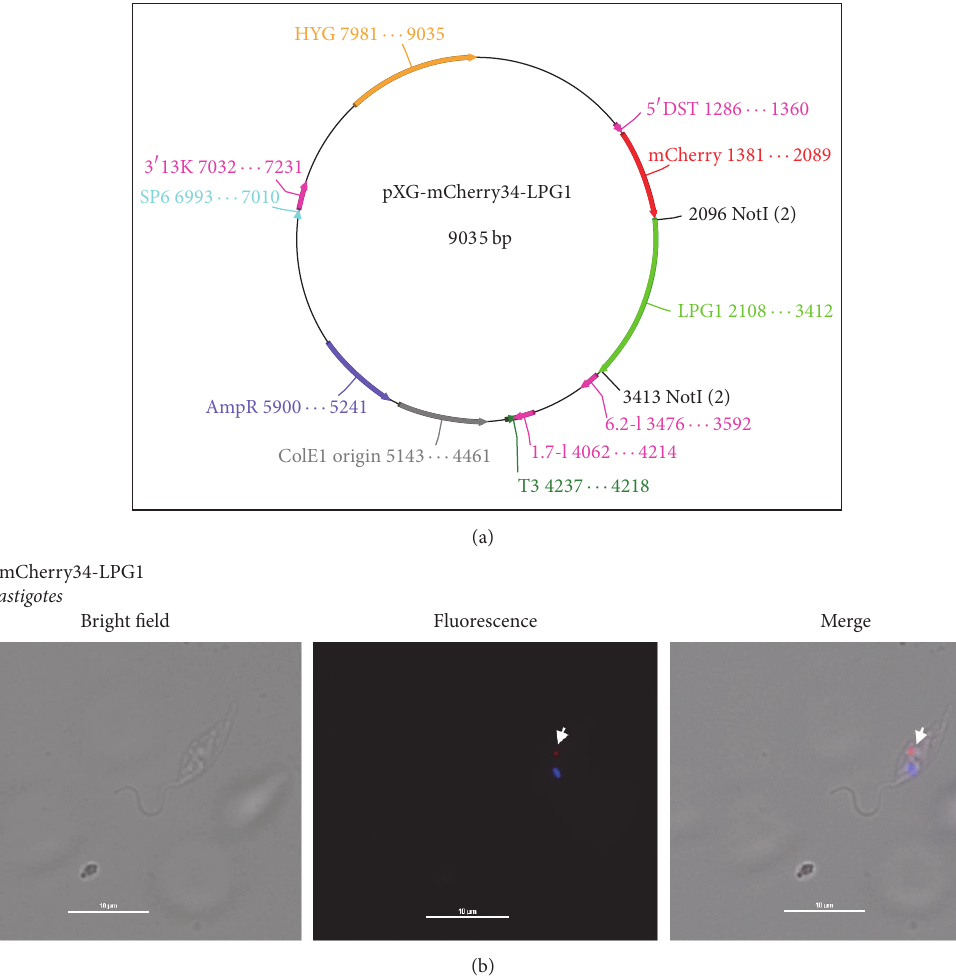
Figure 6: pXG-mCherry plasmids allow the generation of fusion proteins. (a) pXG-mCherry34-LPG1 construct, developed to assess protein localization. (b) Localization of mCherry-LPG1 fusion protein. Golgi apparatus where mCherry-LPG1 expression is observed (solid white arrow). Microscopy images were acquired with a Nikon Eclipse E800 confocal